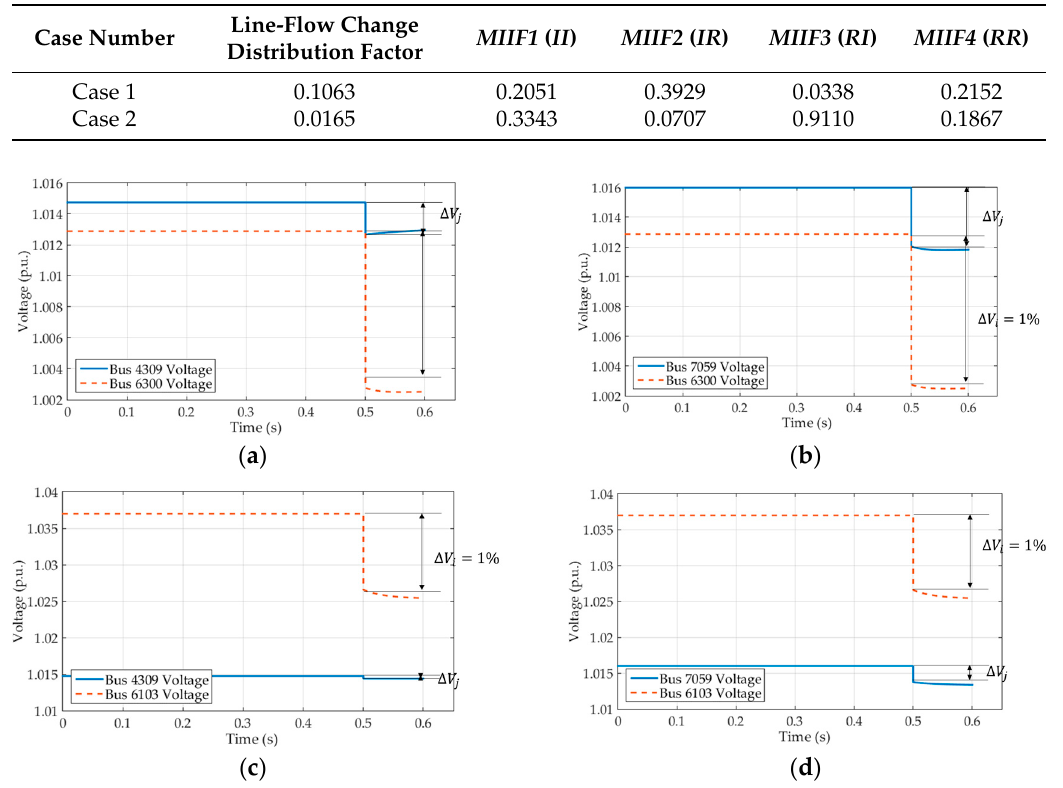
Figure 9. Korean power system case 1 MIIF simulation result by dynamic method: ( a ) MIIF1 simulation result; ( b ) MIIF2 simulation result; ( c ) MIIF3 simulation result; and ( d ) MIIF4 simulation result.